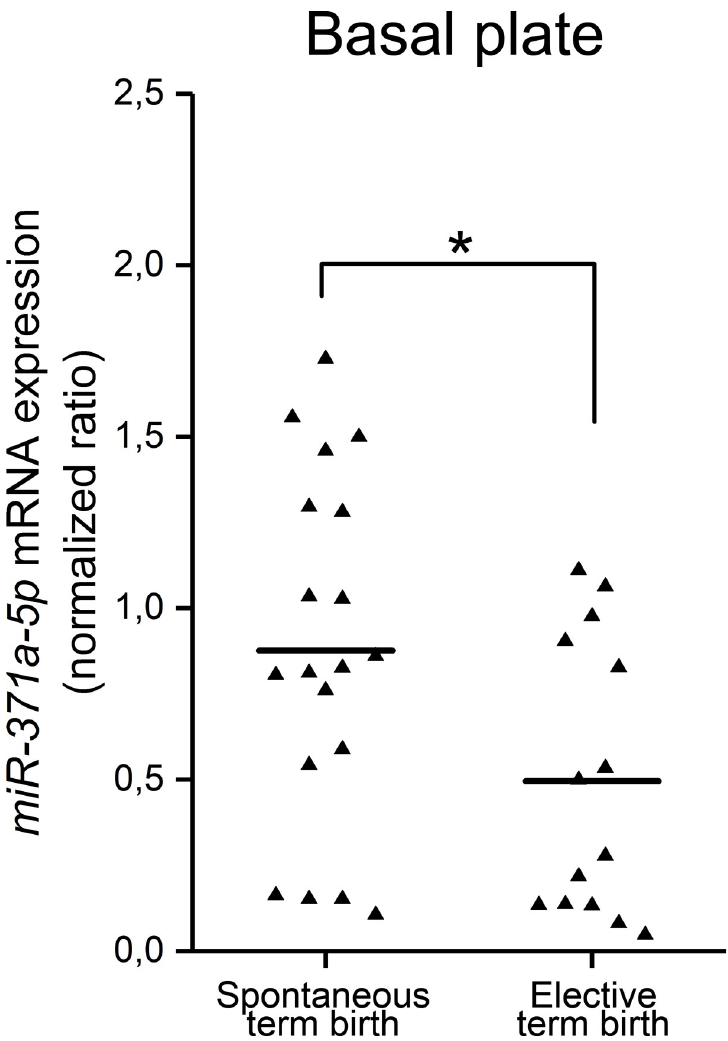
placenta after spontaneous term labor ( n = 6) were compared with miRNAs obtained from elective deliveries ( n = 6) without signs of labor. Mir-371a-5p was the second most upregulated miRNA at spontaneous term labor (fold- change = 2.6, p = 0.003). This result was confirmed in a larger number of placental samples ( n = 19 for spontaneous term labor, n = 14 for elective term labor). During spontaneous term labor, miR-371a5-p levels significantly increased by 1.5-fold ( p = 0.04). Differences were analyzed with nonparametric Mann–Whitney U test. Horizontal line denotes the median of each group. NS, not